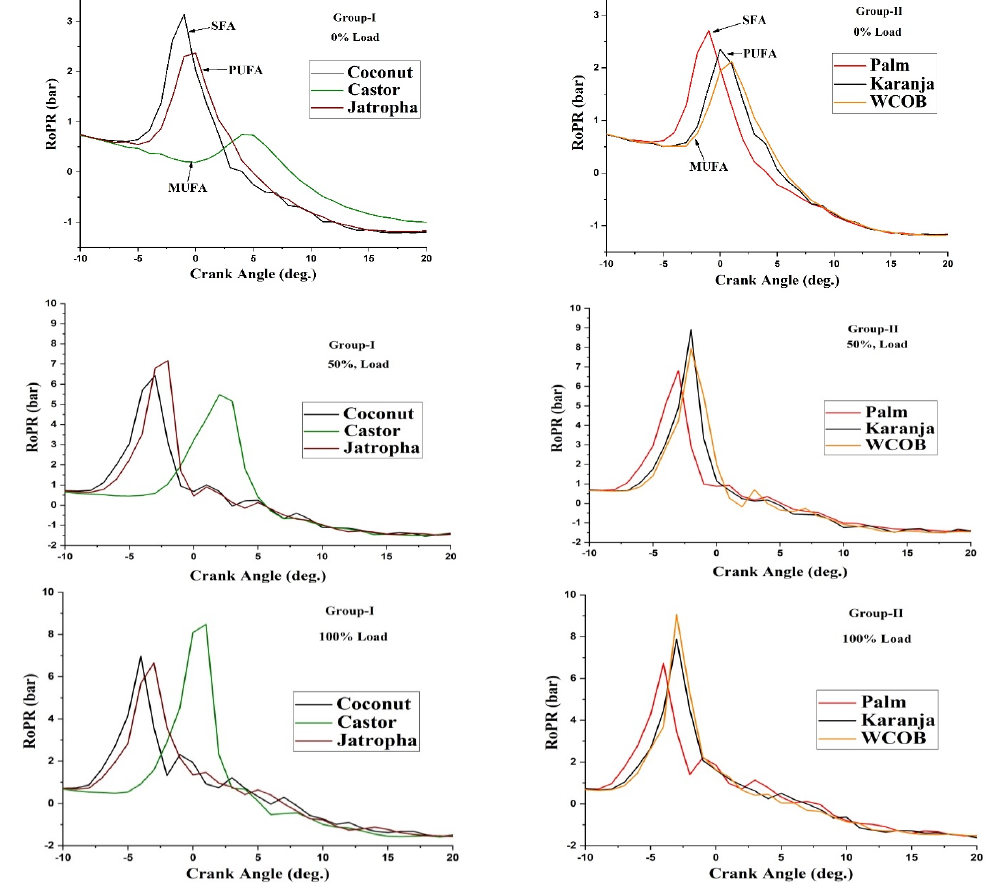
Figure 7. Rate of pressure rise as a function of engine load and biodiesel type.